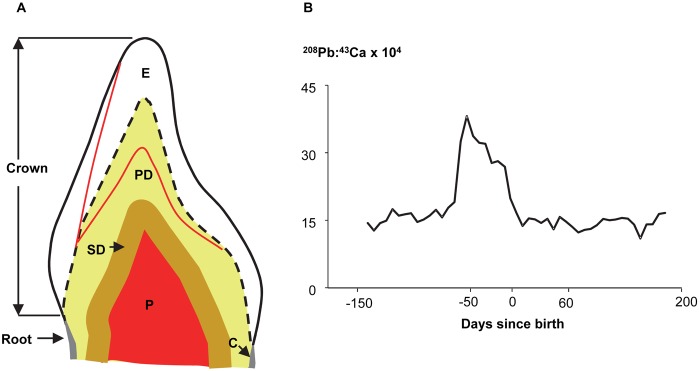
Overview of the dentine Pb biomarker.(a) Schematic of a deciduous human incisor. During tooth formation the deposition of the enamel (E) and primary dentine (PD) matrix commences at the enamel-dentine junction (dashed line). At birth the neonatal line (red line) is formed in enamel and dentine providing a landmark to distinguish prenatally formed parts of teeth from those formed postnatally. In our analysis, prenatally formed primary dentine adjacent to the enamel-dentine junction is sampled to obtain prenatal Pb exposure information. Sampling points in dentine at the neonatal line measure fetal Pb exposure at the time of birth. Secondary dentine (SD) formation starts after the completion of the tooth root and proceeds at a slower rate as long at the tooth remains vital. Measurements in this region are used to estimate cumulative long-term Pb exposure from root completion to the time tooth was shed. Pulp chamber (P) and cervical margin (C) between the tooth crown and root are also indicated. (b) Lead distribution and developmental timing of primary dentine sampled in a deciduous molar. It is our hypothesis that Pb levels at each dentine sampling point represent Pb exposure experienced when that part of dentine was being mineralized. In this individual dentine Pb levels showed a marked rise prior to birth. Key time points for change in dentine Pb levels are shown; other points on the graph can be similarly dated.